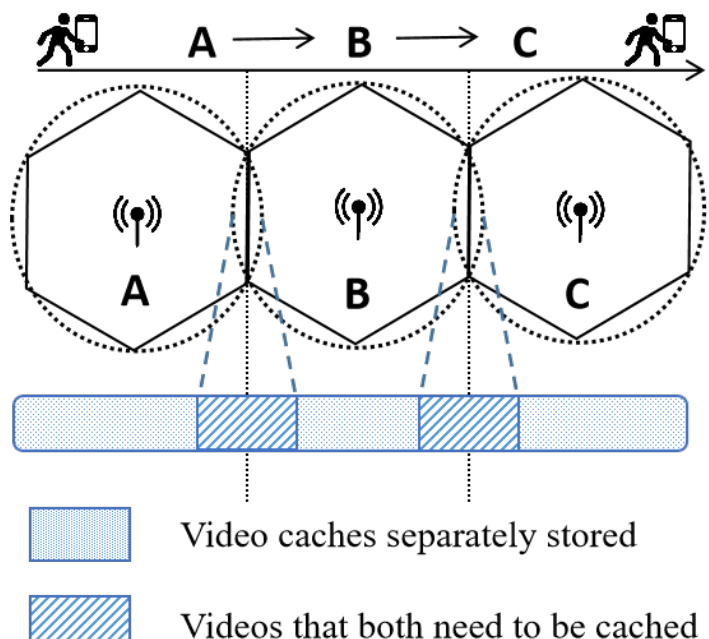
Figure 5. Video segmentation caching mechanism based on user’s